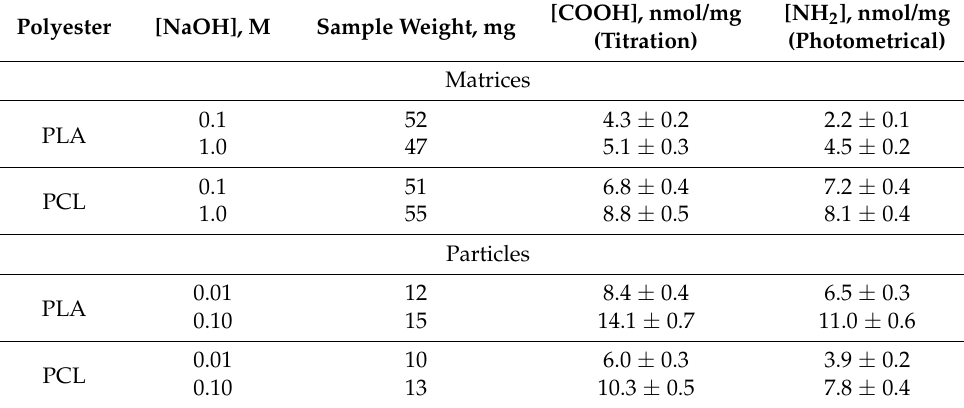
Figure 2. Scheme of biofunctionalization of polyester-based materials with application of oxidized poly(2-deoxy- N -methacriloylamido- D -glucose) (ox-PMAG). Table 1. The effect of sodium hydroxide concentration on the amount of introduced COOH- and followed NH 2 -groups in the PLA/PCL-based matrices and particles.